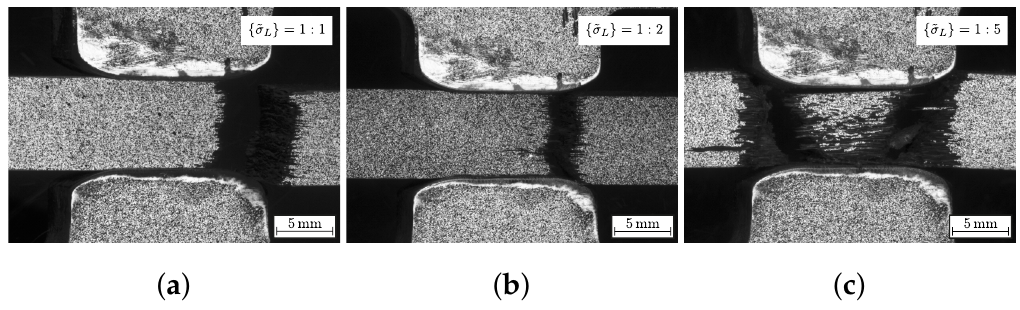
) -testing: ( a ) tension 3